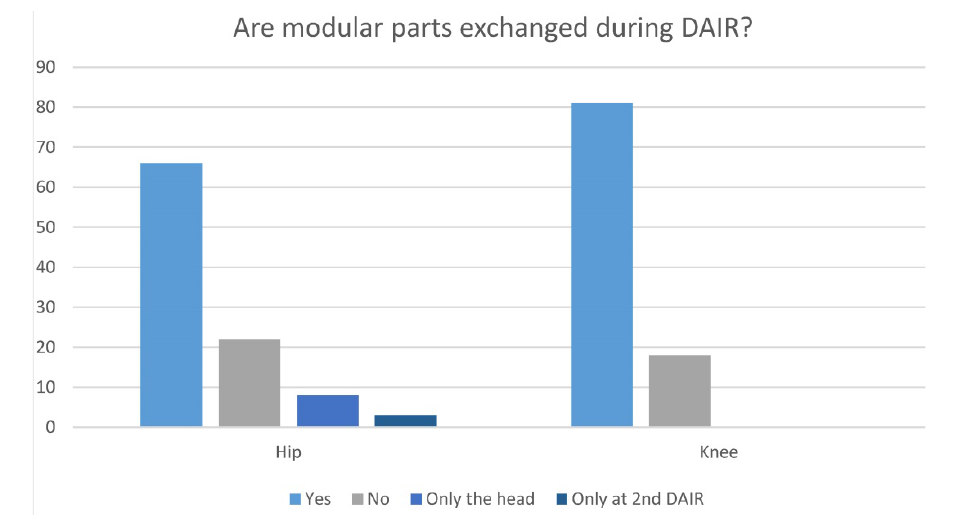
Figure 2. Exchange of modular